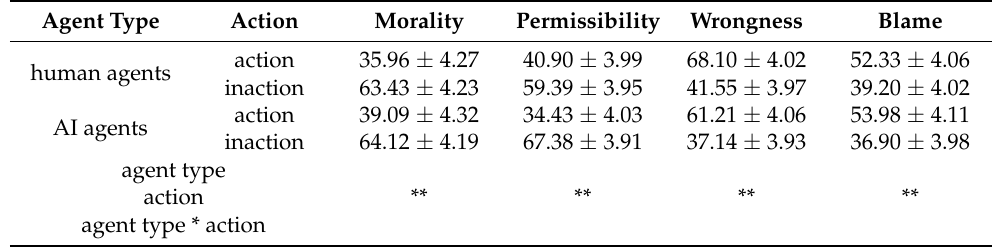
Table 2. Rates of morality, permissibility, wrongness, and blame on human and AI agents in Experiment